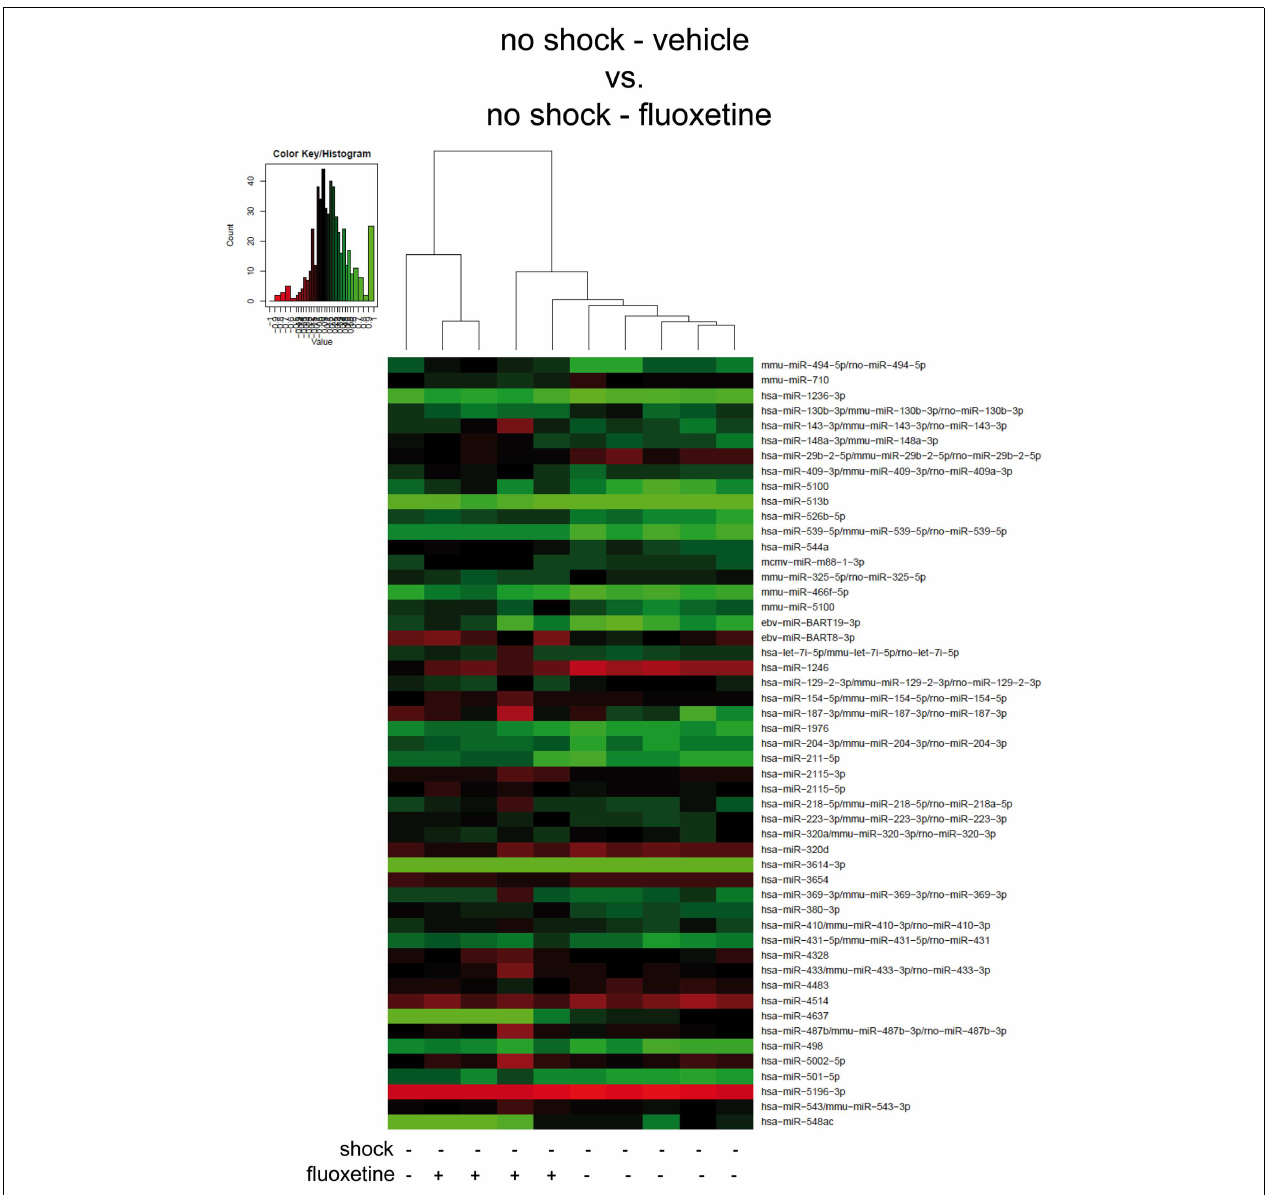
day 74 after footshock (“shock”) or mock treatment (“no-shock”) of male C57/BL6/N mice (no-shock-vehicle: n = 6 per group: no-shock-fluoxetine: n = 4). Each row represents a miRNA and each column represents a sample. Dendrograms represent complete-linkage clustering (by Euclidean distance) between samples.The sample clustering tree is shown on the top.The color scale illustrates the intensities of the relative miRNA expression levels: decreased scores are represented in red and increased in green, with intensity encoding magnitude. See Section “Materials and Methods” for statistical procedures.Vehicle, drinking water (solvent of